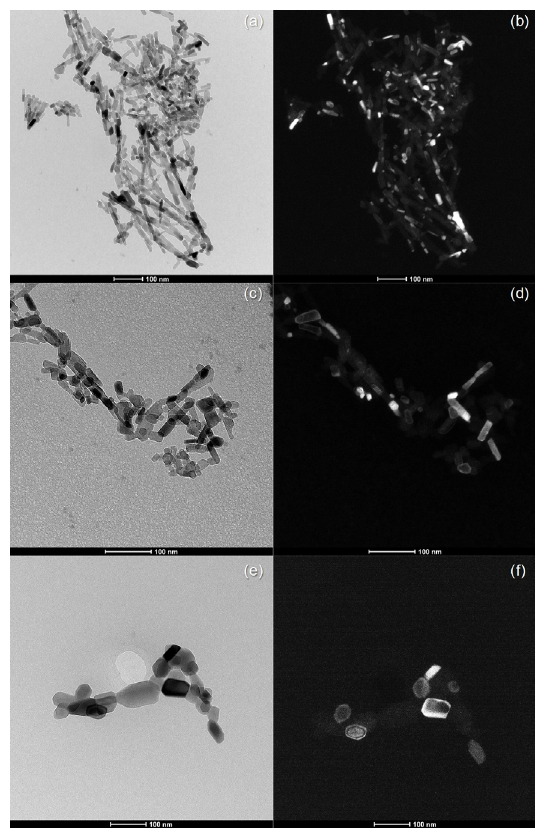
Figure 2. Bright-field (left) and Hollow-cone Dark-field (right) TEM images of the samples NR550 (a, b), NR650 (c, d) and NR750 (e, f).